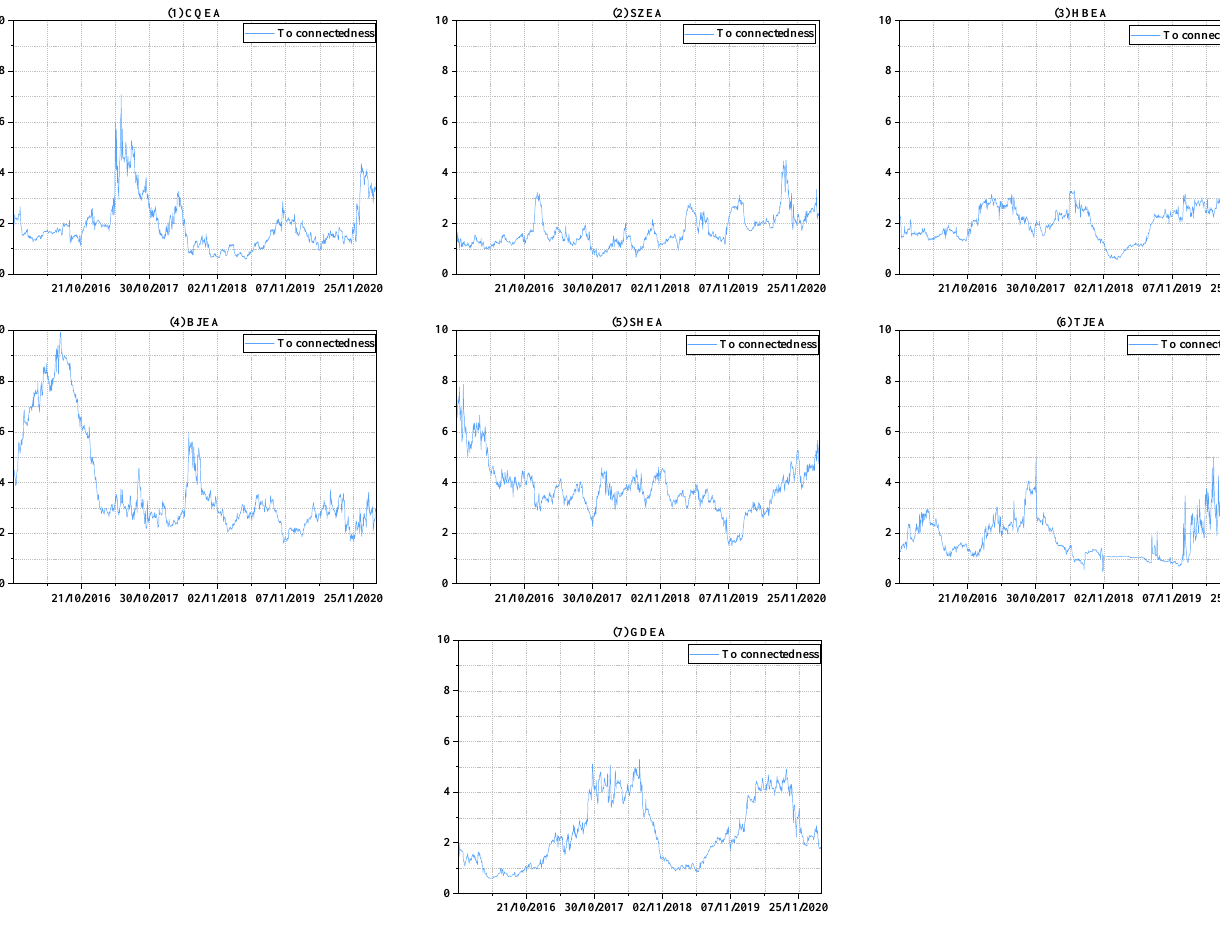
Figure 3. The dynamics of “to